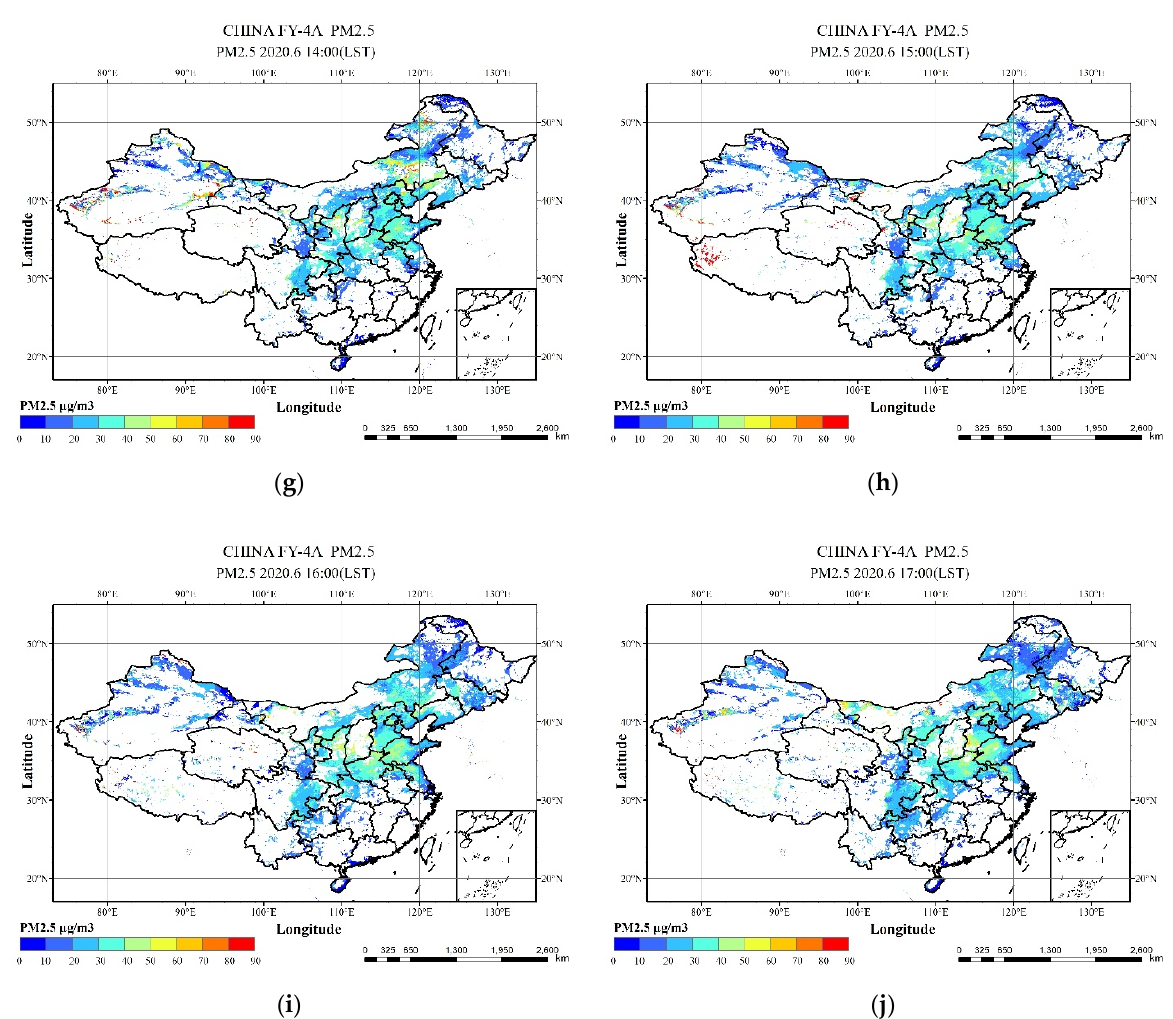
Figure 5. Average hourly PM 2 . 5 concentration in 5–6 and 9–10 June 2020, 8:00–17:00 (LST), from ( a ) to ( j ).